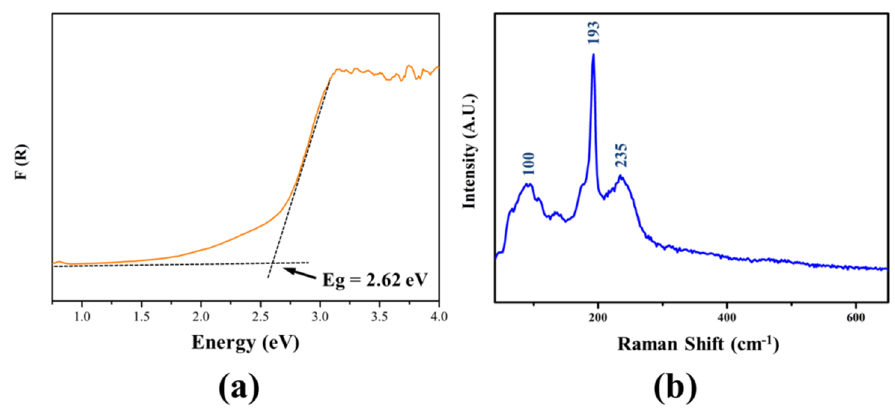
Figure 2. ( a ) Experimental band gap of Li 2 MgSnSe 4 samples; and ( b ) Raman spectrum of Li 2 MgSnSe 4 single crystal.